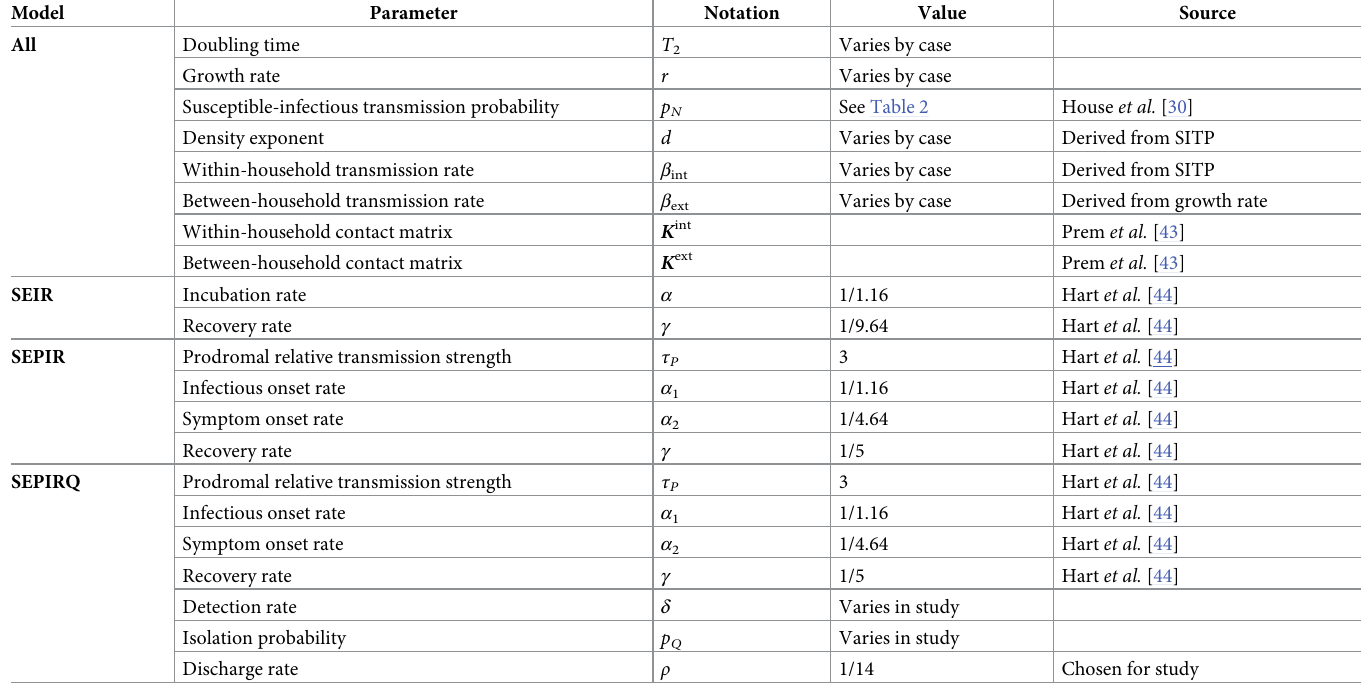
Table 1. Parameter notation, choices, and sources for the age- and household structured infection model.